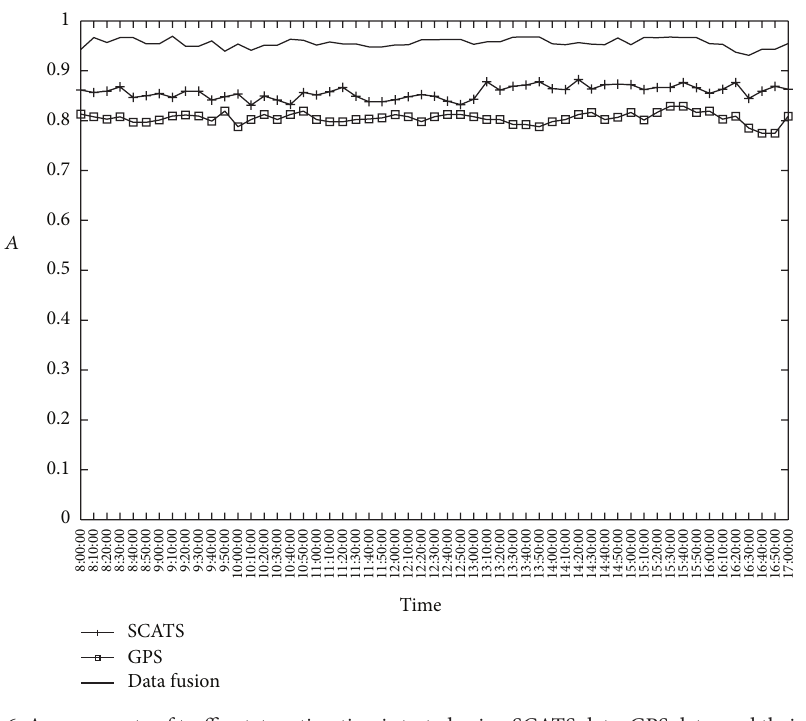
Figure 6: Accuracy rate of traffic state estimation is tested using SCATS data, GPS data, and their fusion. Table 1: Average execution time and speedup using 1, 2, 4, 8, 16, and 32 computing nodes.